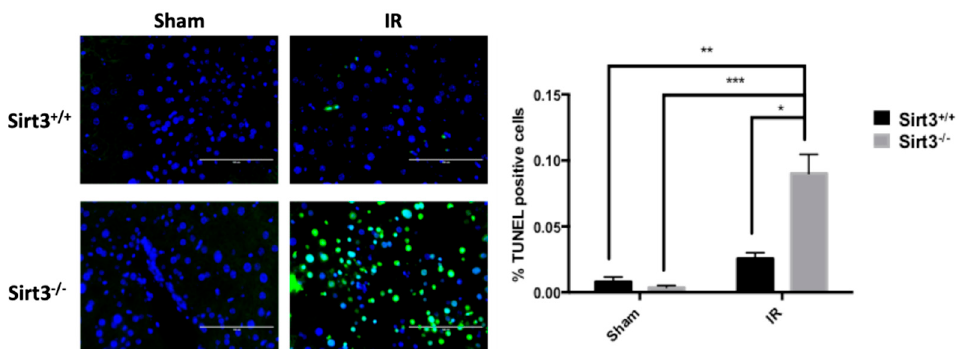
Figure 7. The number of TUNEL positive cells were significantly increased in Sirt3 − / − mice after irradiation compared to sham irradiated Sirt3 +/+ or Sirt3 − / − as well as Sirt3 +/+ irradiated groups. Scale bar: 100 μ m ( n = 4–6; * p < 0.05 ** p < 0.01, *** p < 0.001).